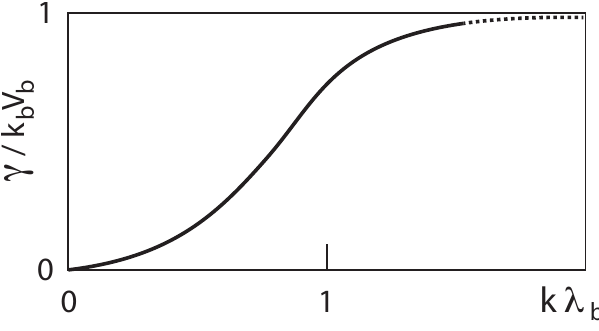
Fig. 2. The growth rate of the Weibel filamentation instability as function of wavenumber kλ b ≡ kλ eb